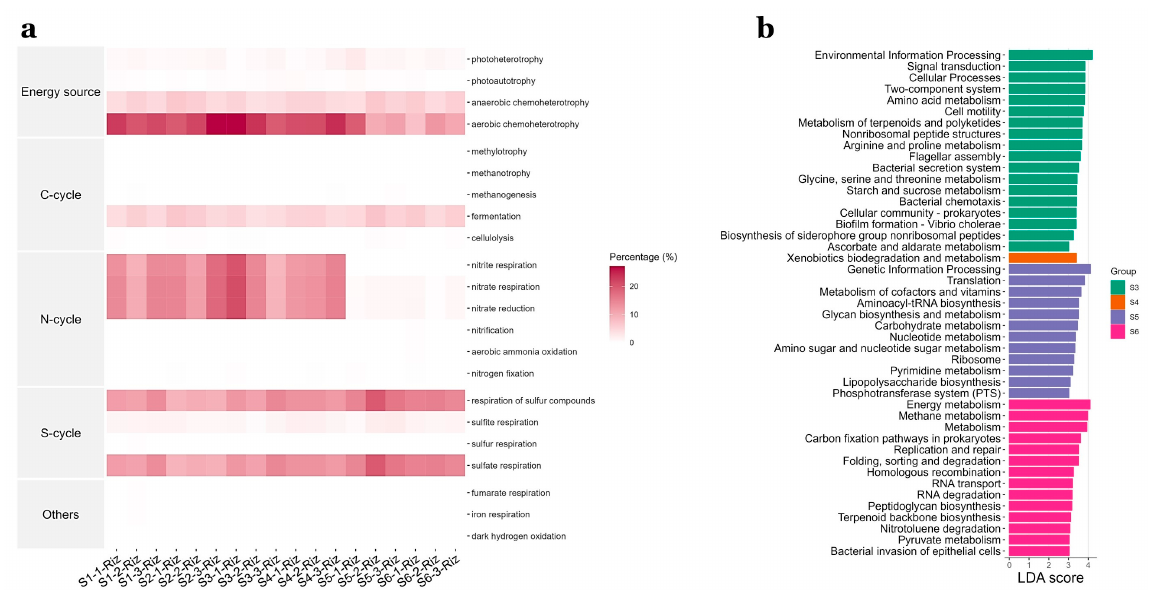
Figure 7. Predicted functional profiles for all sampling sites (S1–S6) using FAPROTAX database using the abundance of taxa. Percentages of taxa with specific traits are shown in the heatmap ( a ) and LEFSE analysis for the same dataset to show the differences across sites. Functional profiles using subsystem level 3 of KEGG Orthologues using Tax4Fun database are shown ( b ).